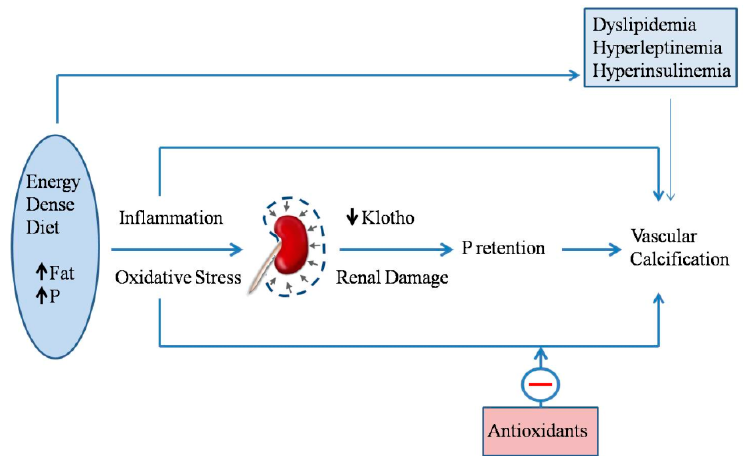
Figure 4. Energy-dense diets, that are rich in fat and phosphate (P), elicit inflammation and oxidative stress. In addition to the direct effects of inflammation and oxidative stress on vascular calcification, they also affect the kidney, inducing renal damage and decreasing klotho expression, thus resulting in P retention, which in turn, also promotes vascular calcification. Other biochemical changes related to eating energy-dense diets (e.g., dyslipidemia) are also likely to promote vascular calcification. Finally, antioxidants (e.g., vitamin E) have been shown to protect against vascular calcification in uremic animals eating energy-dense diets.